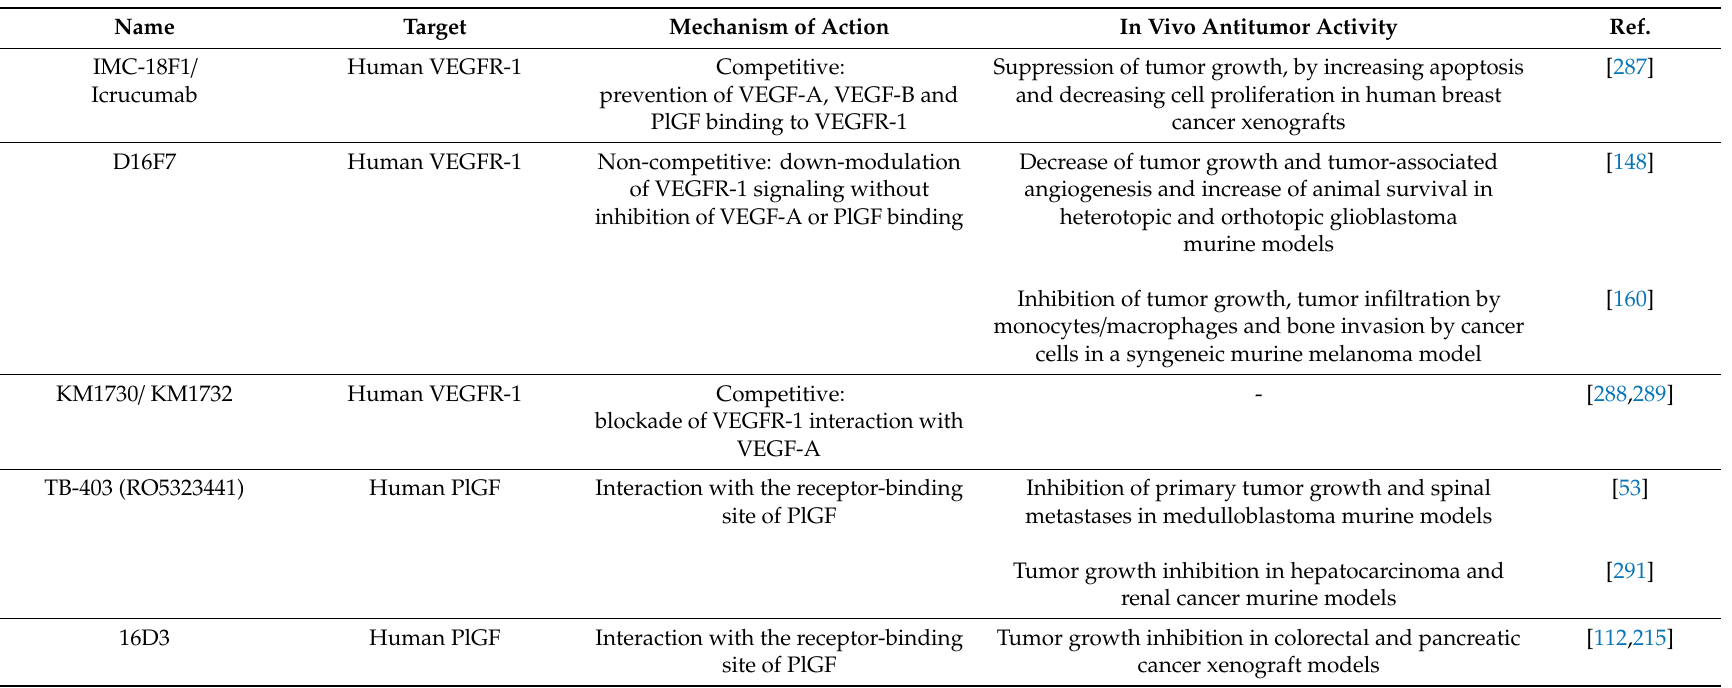
Table 4. Experimental mAbs designed to inhibit human VEGFR-1